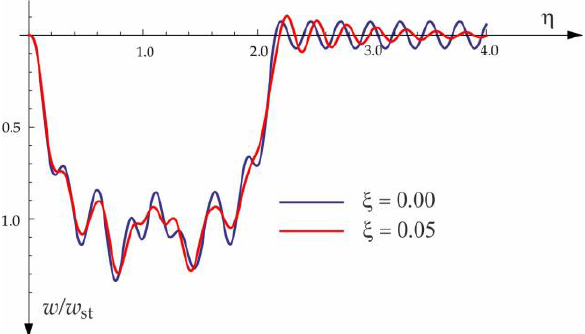
Figure 17. Damping influence on deflection of midpoint of the beam on three-parameter Vlasov foundation subjected to the group of three forces moving at a velocity of v = 50 m/s and a distance of a = 3